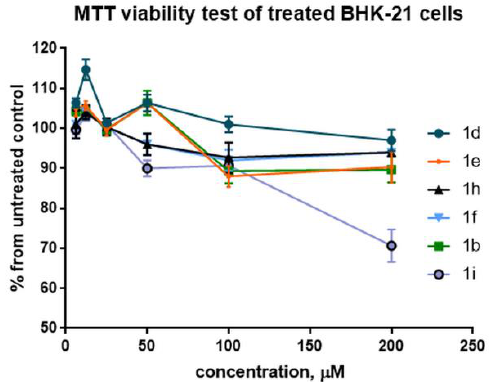
Figure 7. MTT viability test of BHK-21 cells treated with selected HAP compounds 1b , 1d , 1e , 1h , 1f , and 1i . The BHK-21 cells were incubated with medium containing the respective amount of the compound (6.125; 12.5; 25; 50; 100; 200 μM) for 24 h, then the cell viability was measured by MTT - based assay. The results are shown as a percentage of optical density (OD) units compared with the non-treated control BHK-21 cells (100%); error bars represent the standard deviation of three repeats.